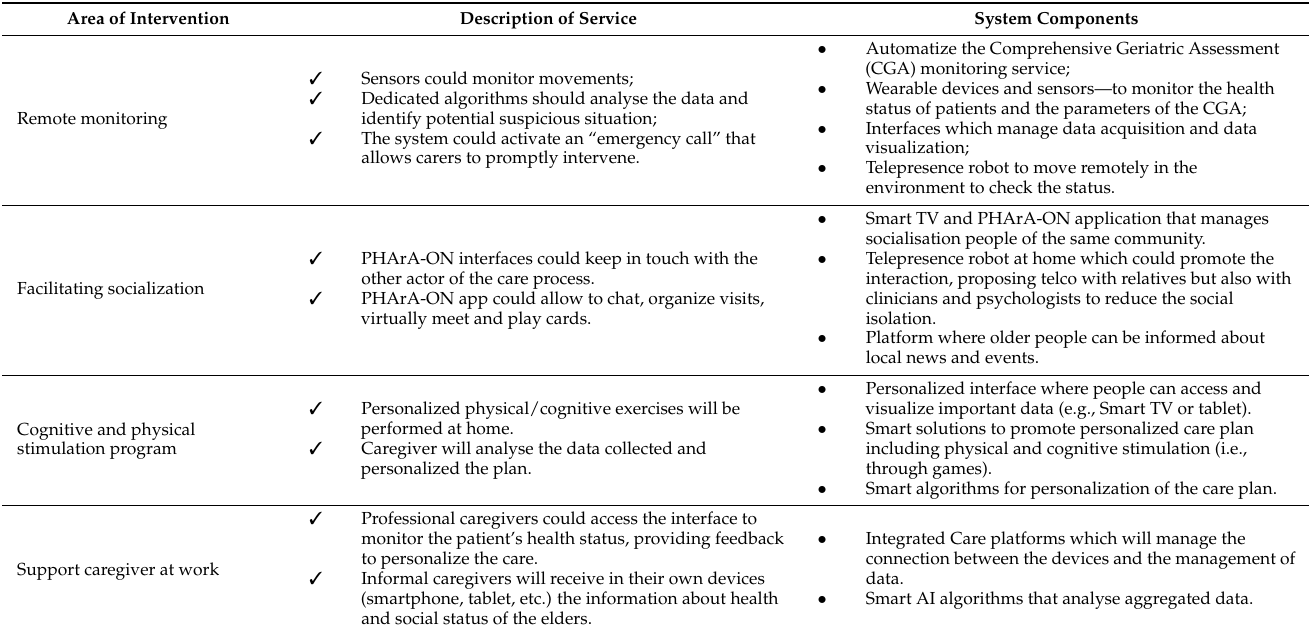
Table 1. Technologies customized to fulfil services in specific intervention areas. Area of Intervention Description of